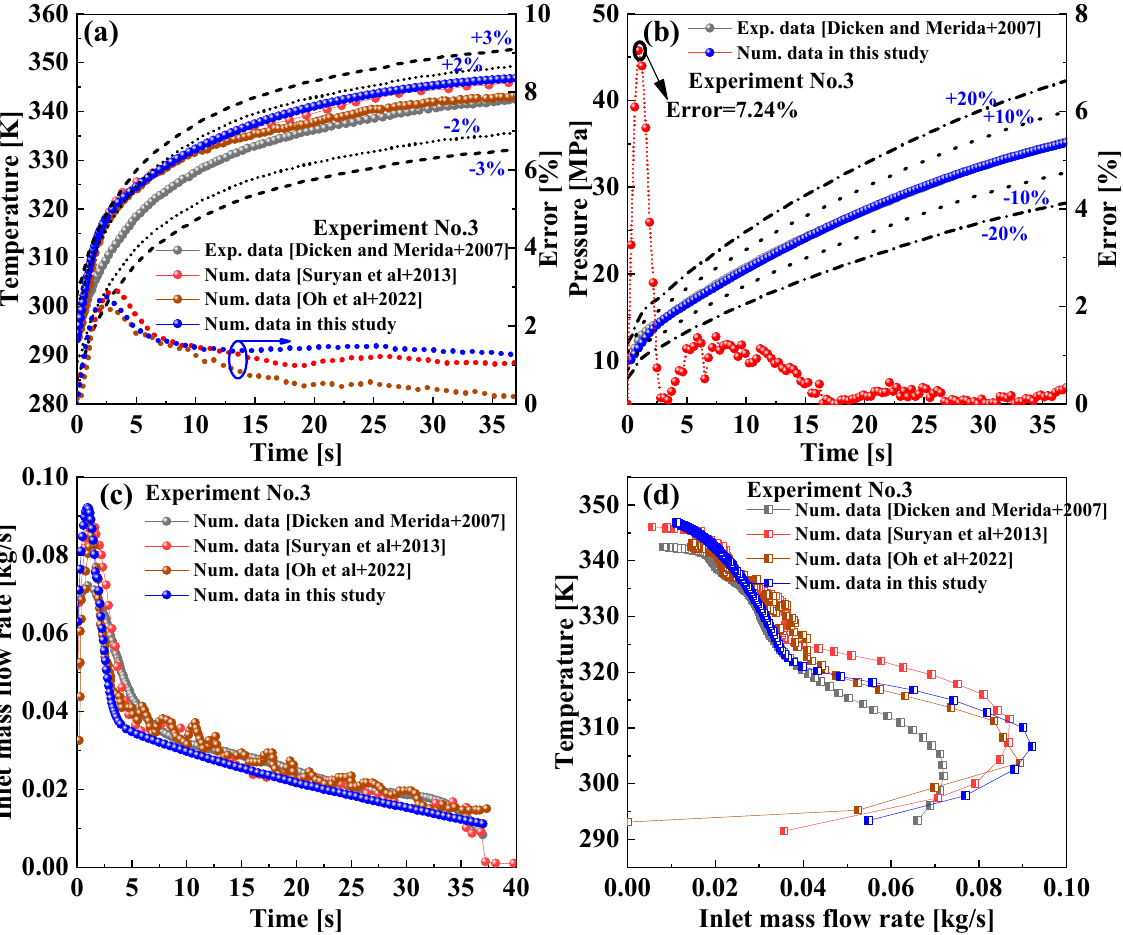
Figure 5. Parameter comparisons: mean temperature (a), pressure (b), inlet mass flow rate (c), and correlation between the mean temperature and inlet mass flow rate (d) [Dicken and Merida, 2007; Suryan et al., 2013; Oh et al., 2022].